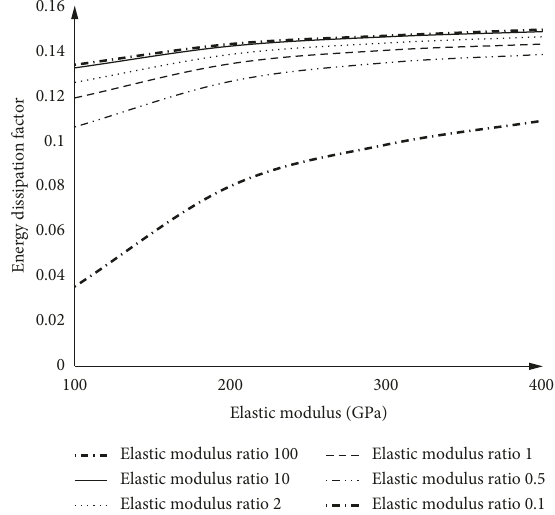
Figure 13: Curve of energy dissipation factors under different elastic modulus ratios.